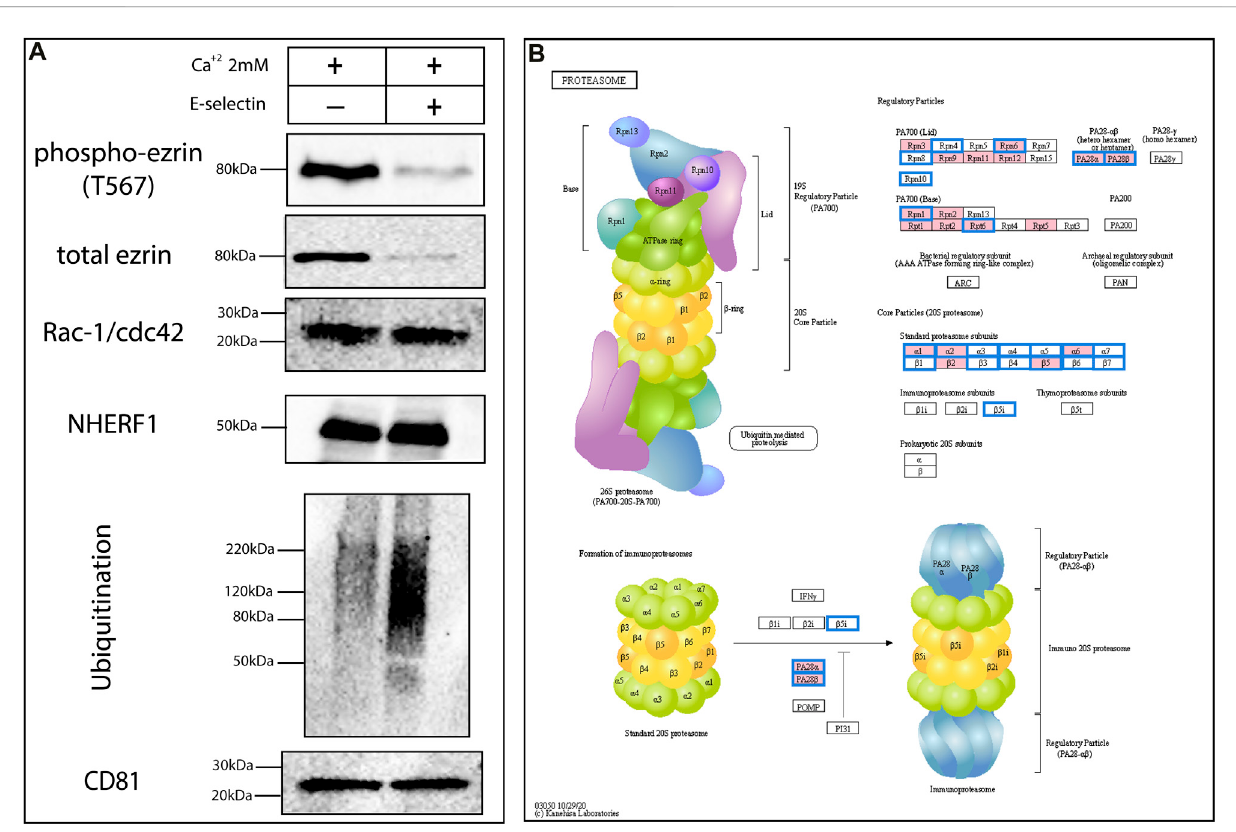
FIGURE 6 Exosomes mayaltertheircargoduring transporttorecipientcellsinanon-stochasticmanner. (A)